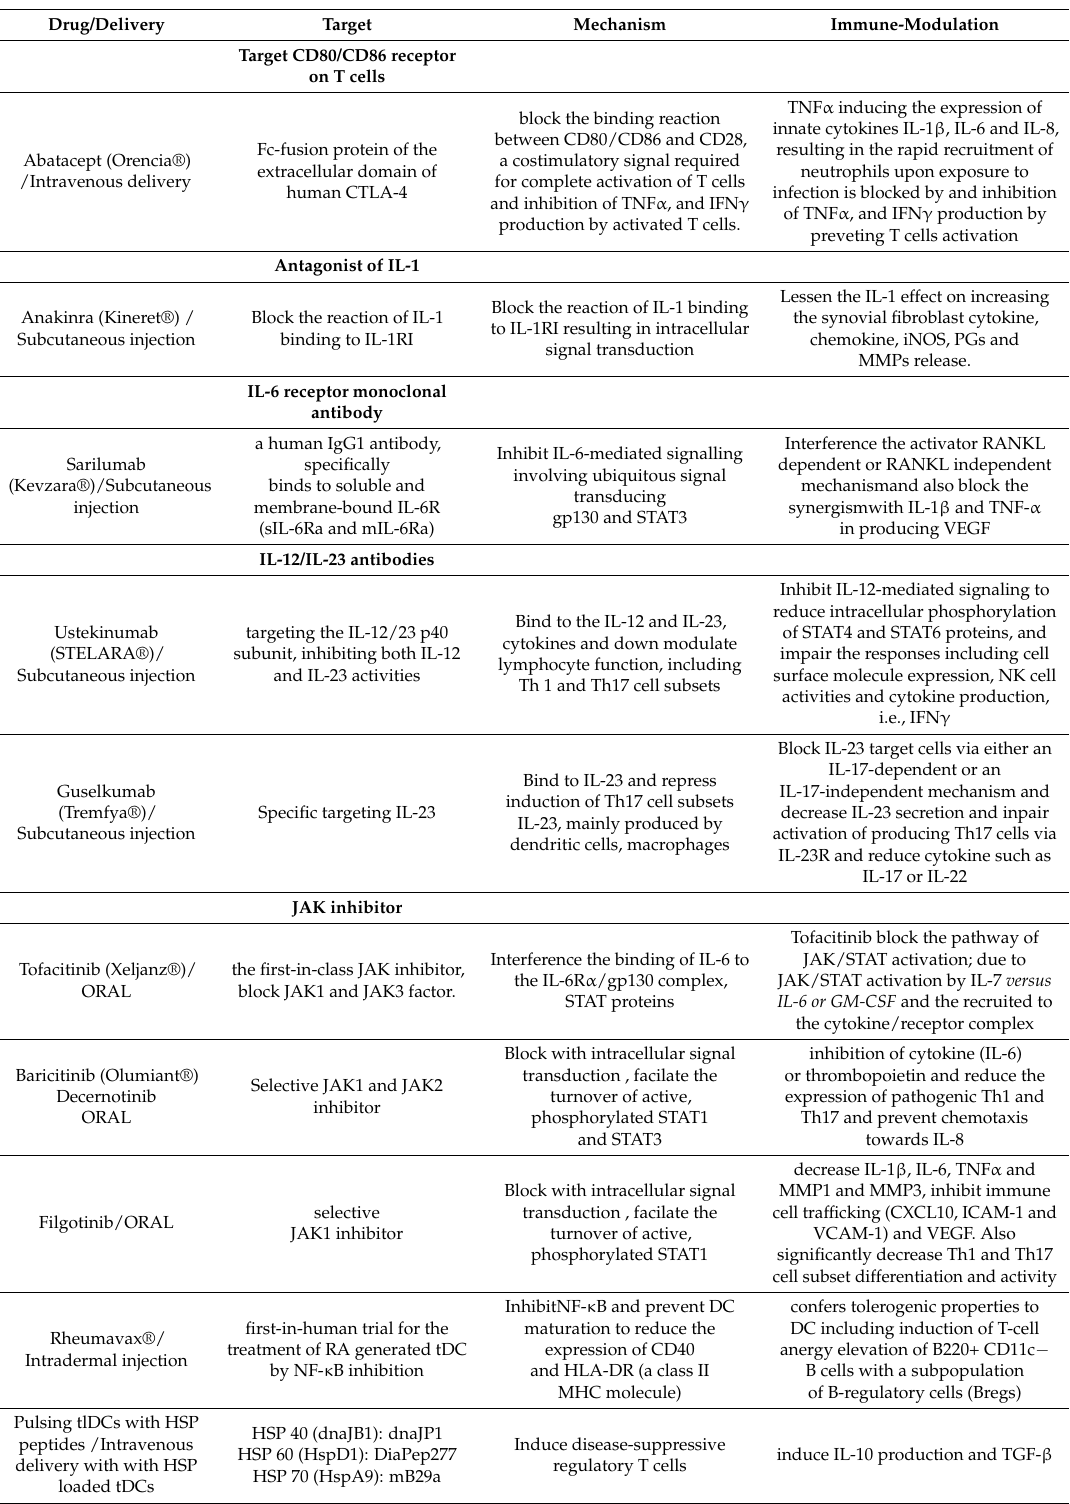
Table 1. Summary of novel treatment for